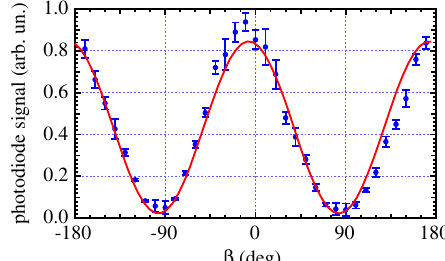
FIG. 8. Typical data set of a β scan acquired with the optical polarimeter. The normalized detector signal averaged over 50 FEL shots (blue points), and the rms errors for each β value are plotted versus the polarizer angle β . In red, the best fit is also shown. Reported data refer to the 26-nm vertical polarization with α ¼ 7